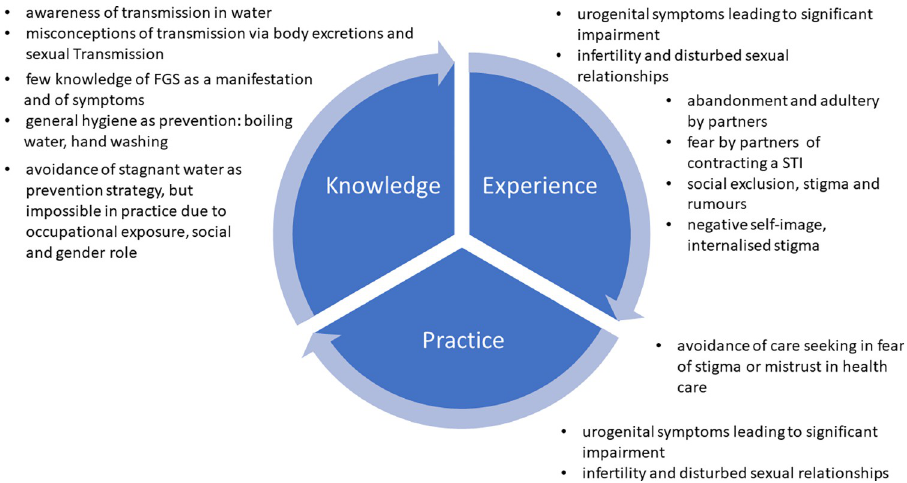
Fig 4. Key results on knowledge experience and practice among women affected by